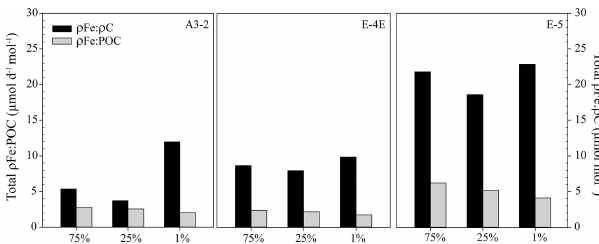
Figure 6. Comparison between total Fe:C uptake ratios, noted ρ Fe: ρ C (black bars), and Fe uptake by the bulk community nor- malized to C biomass noted ρ Fe:POC (grey bars) at three differ- ent surface PAR levels at stations A3-2 (plateau), E-4E and E-5 (plume).